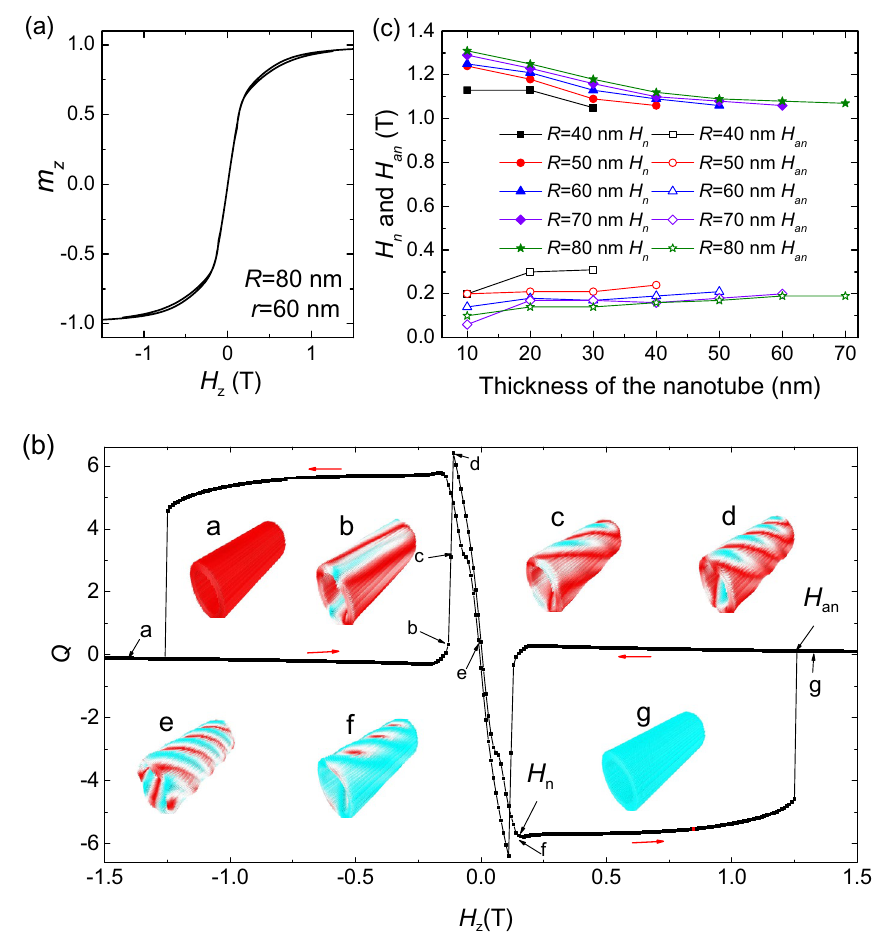
Figure 2. ( a ) The typical hysteresis loop of a nanotube ( R = 80 nm, r = 60 nm) under a z -direction magnetic field. ( b ) The topological number as a function of H z and the evolution of the magnetic structure during this process. ( c ) The size dependence of nucleation field H n and the annihilation field H an for nanotubes with different